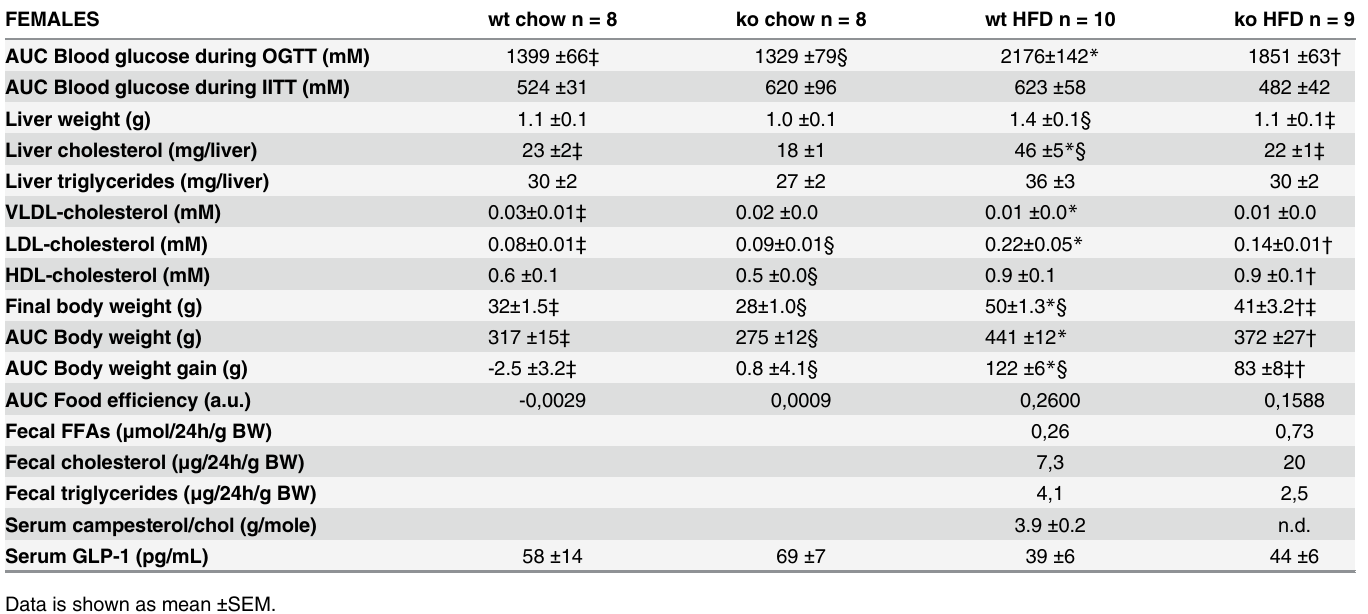
Table 1. Responses to a high fat diet (HFD) in female Cyp8b1-/- mice (ko) and their wildtype (wt)